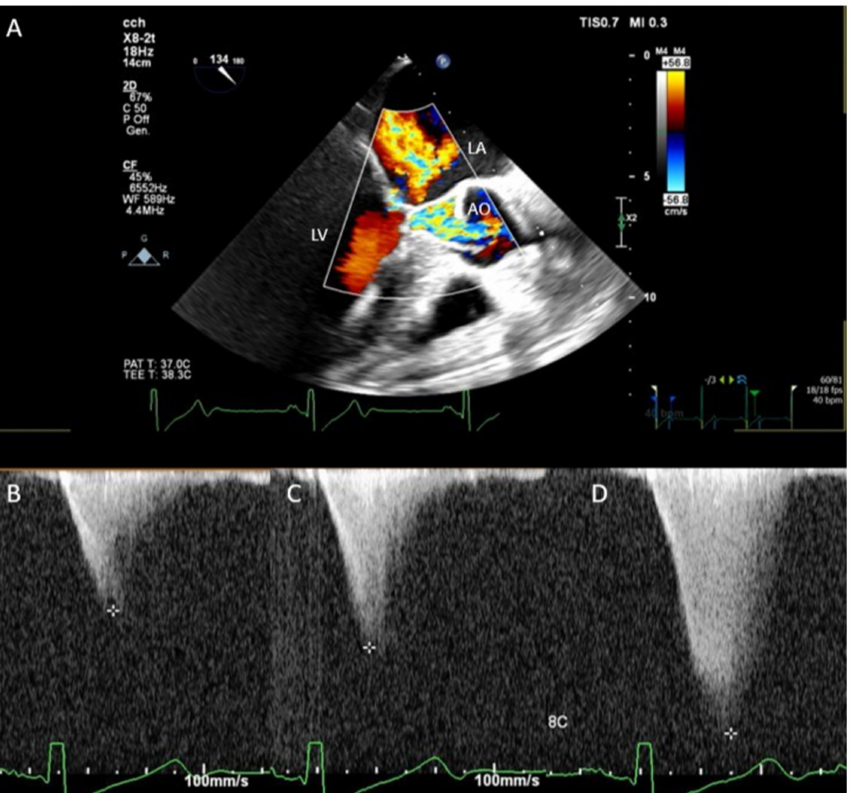
Figure 1. ( A ) Transesophageal color Doppler method showing the systolic anterior motion of the mitral valve and aliased flow in the left ventricular outflow tract during systole. Continuous wave Doppler showed a gradient ranging between 50 ( B ), 80 ( C ), and 180 mmHg ( D ) in different steps of the surgical procedure. LA, left atrium; LV, left ventricle; AO,